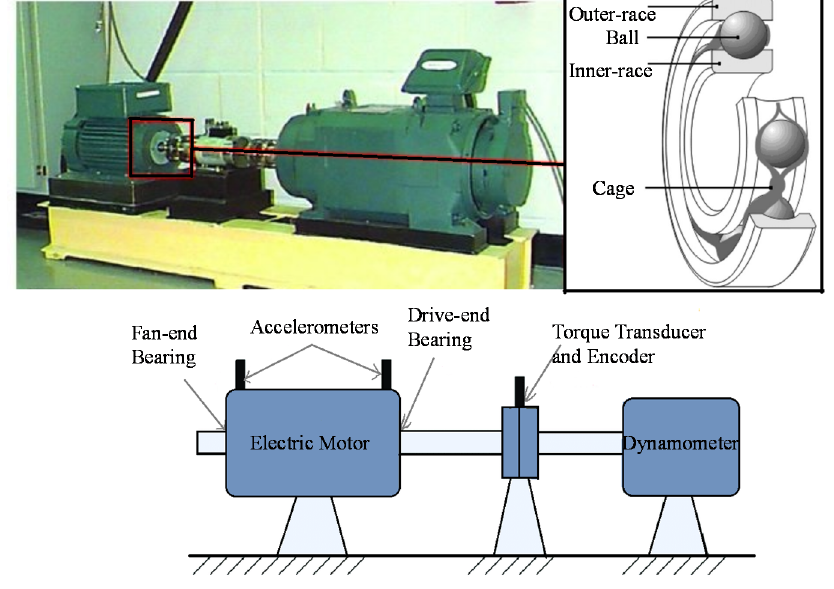
Figure 1. CWRU bearing test rig system and components of REB.